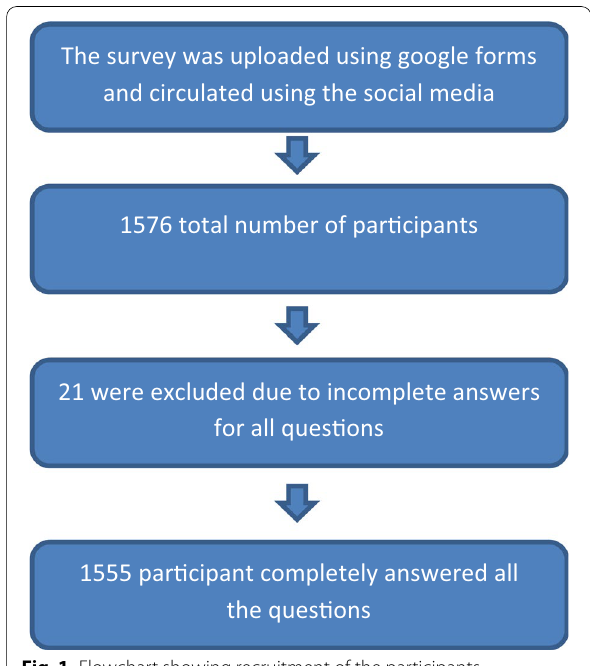
Fig. 1 Flowchart showing recruitment of the